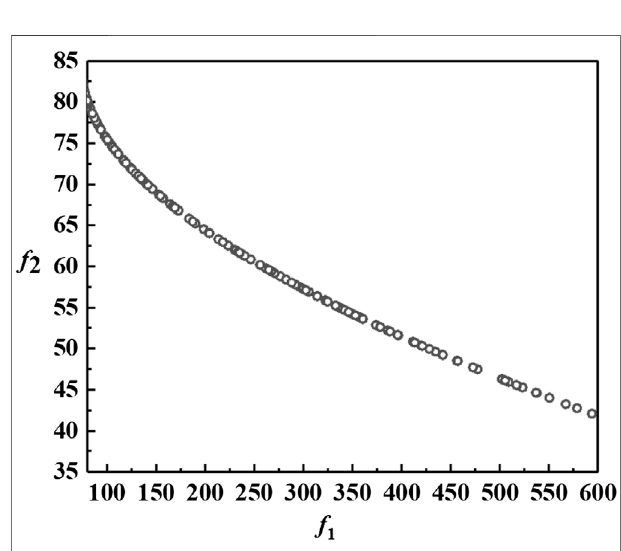
FIGURE 17 | Parameter optimization results of the structure.